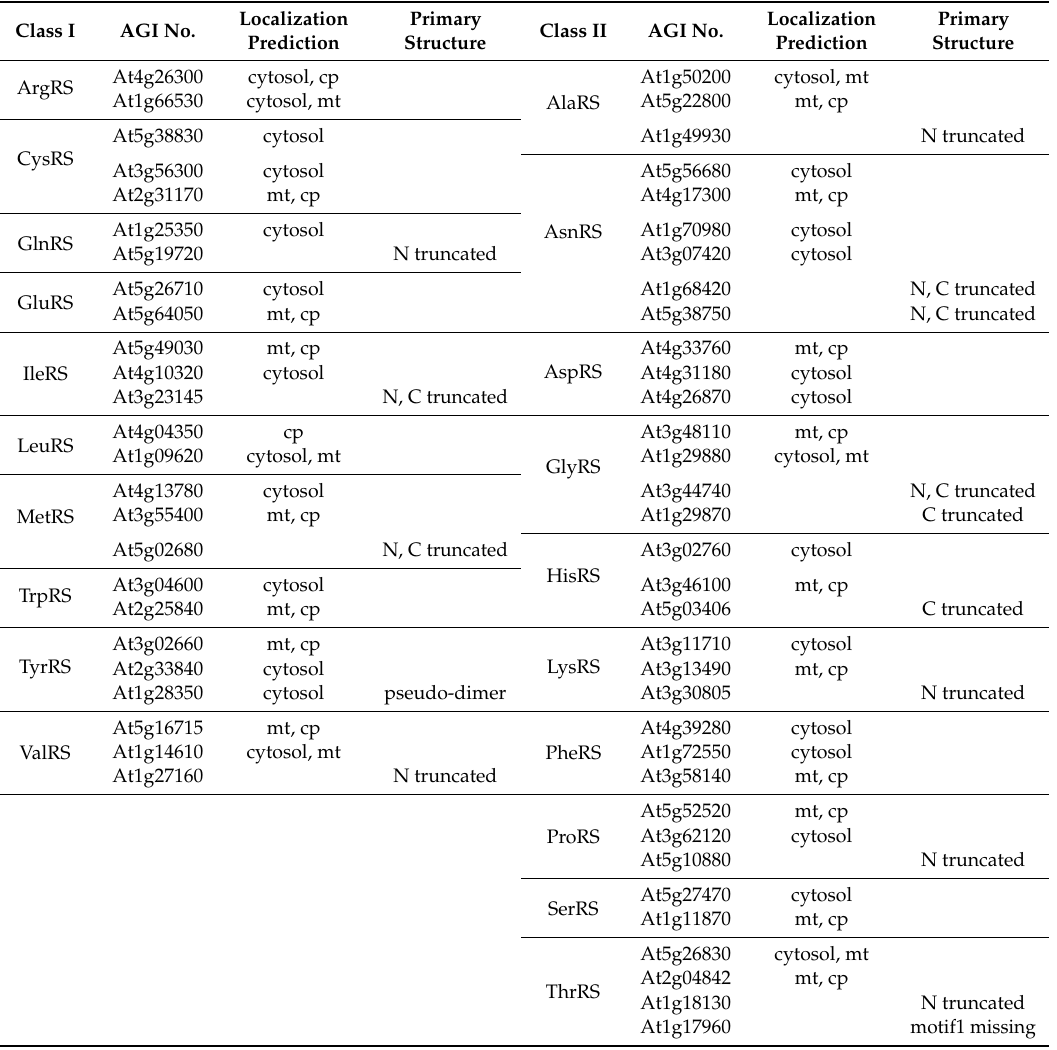
Table 1. Arabidopsis aaRSs identified in the database. Characteristic primary structures are